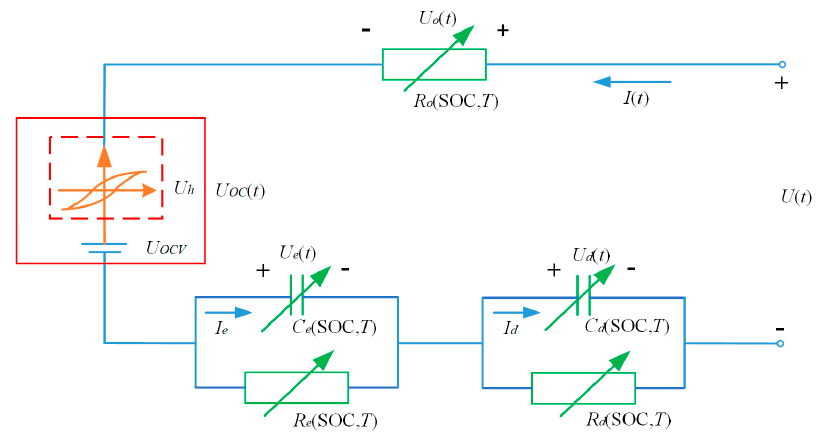
Figure 5. Temperature–hysteresis equivalent circuit model.